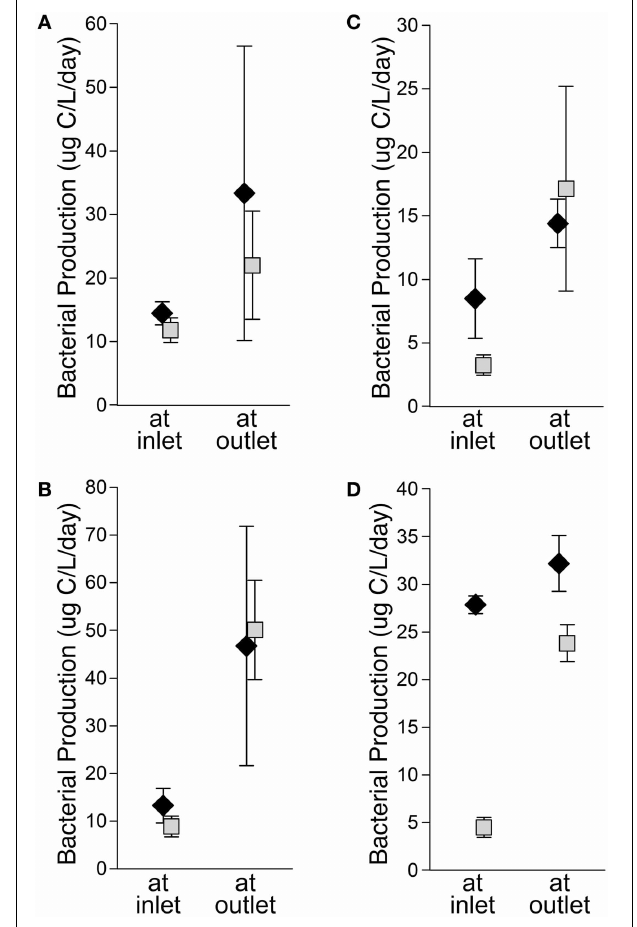
FIGURE 4 | Left: Early summer transplants at I-8 inlet and outlet from 5 to 9 July 2005 (A) and 2–4 July 2007 (B). Right: Late summer transplants at I-8 inlet and outlet from 26 to 28 July 2005 (C) and 1–3 Aug. 2006 (D) . For all graphs, diamonds are inlet communities and squares are outlet communities. Error bars are standard error of the